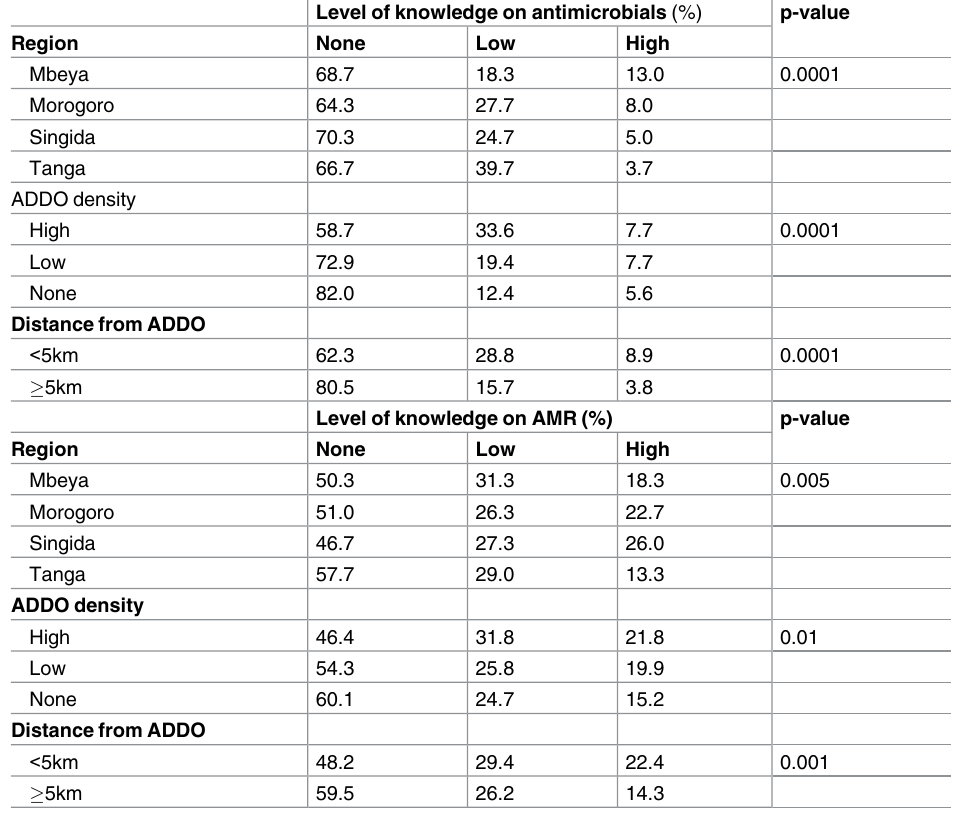
Table 3. Overall levels of knowledge of antimicrobials and AMR by region, ADDO density, and dis- tance from an ADDO * .